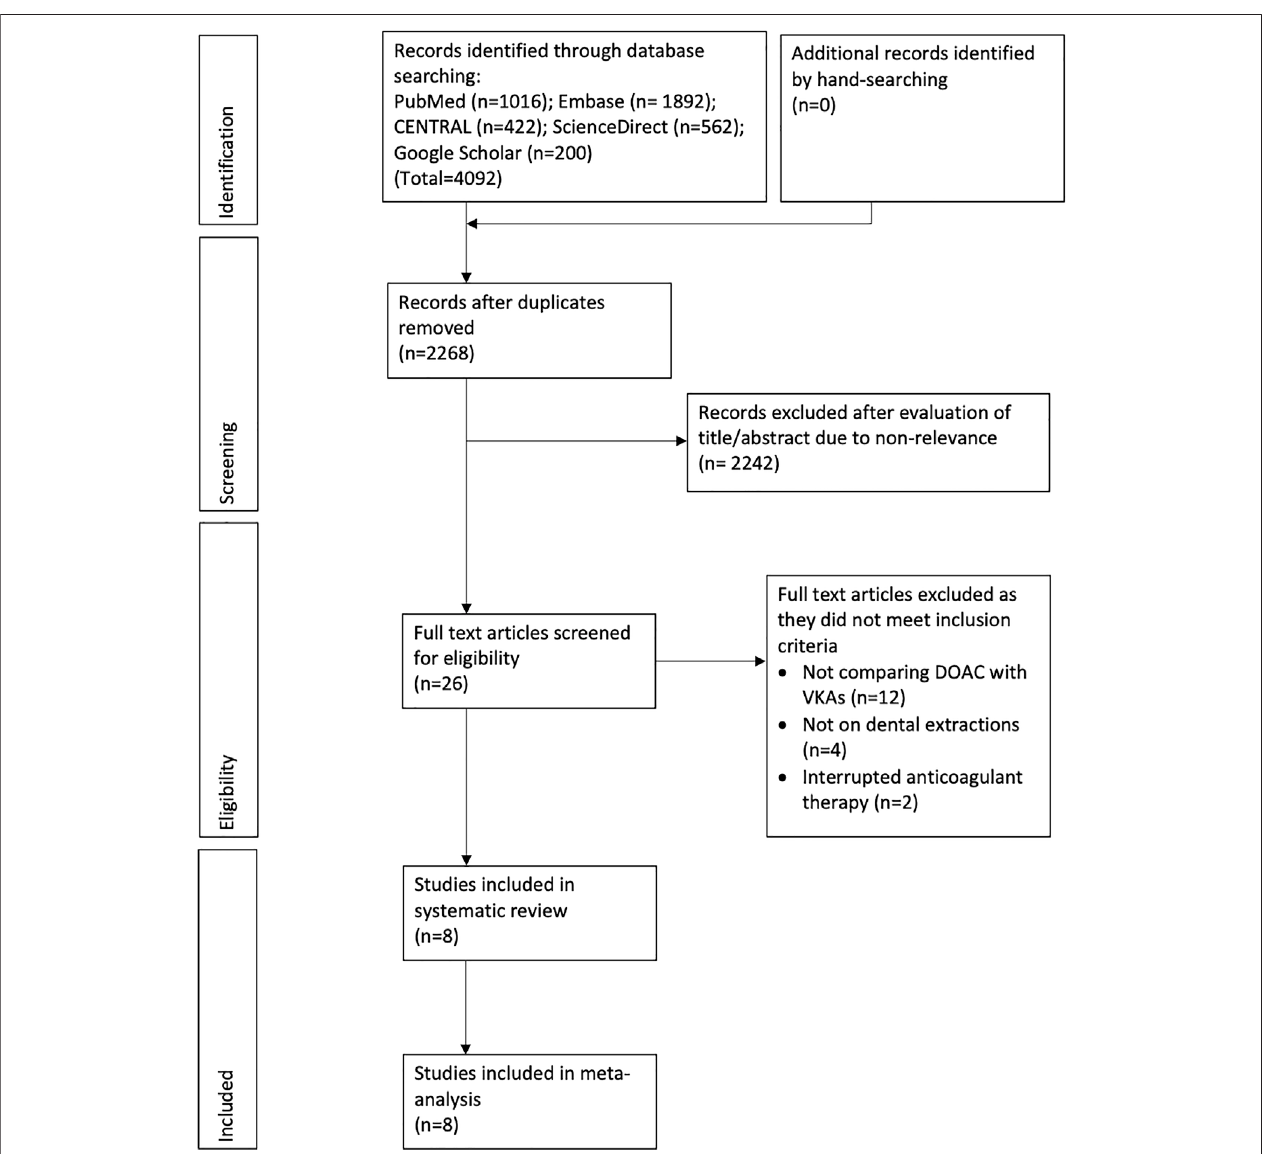
FIGURE 1 | Study fl ow